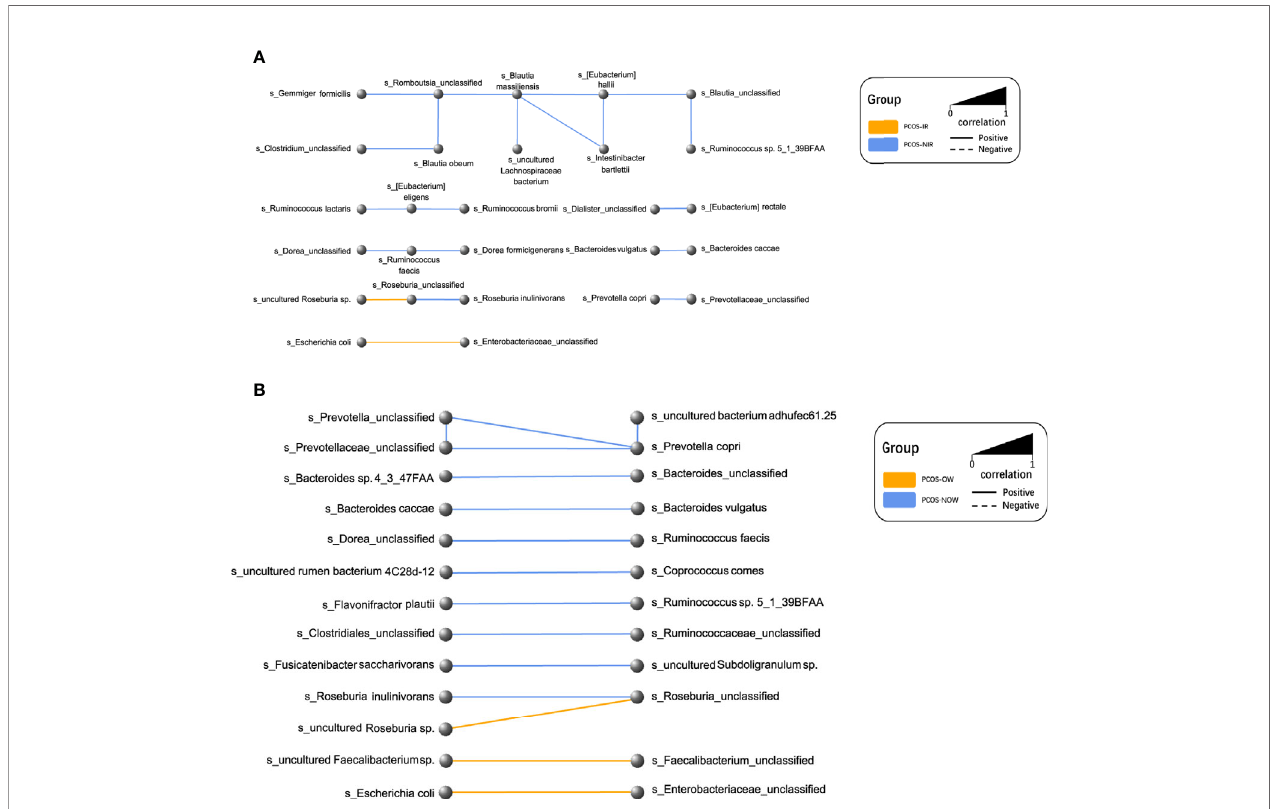
FIGURE 7 | Network plot of species. Every node represented a species. Two species that had a positive relationship were connected with a solid line, and a negative relationship with a dashed line. The width of the line represented the strength of association. (A) Relationships between PCOS-IR and PCOS-NIR. (B) Relationships between PCOSOW and PCOS-NOW.